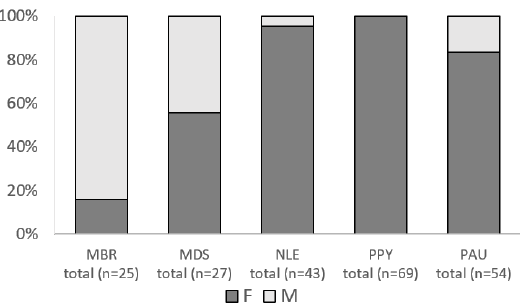
Figure 11. Sex ratio of five bat species calculated using the total sample of adult individuals.